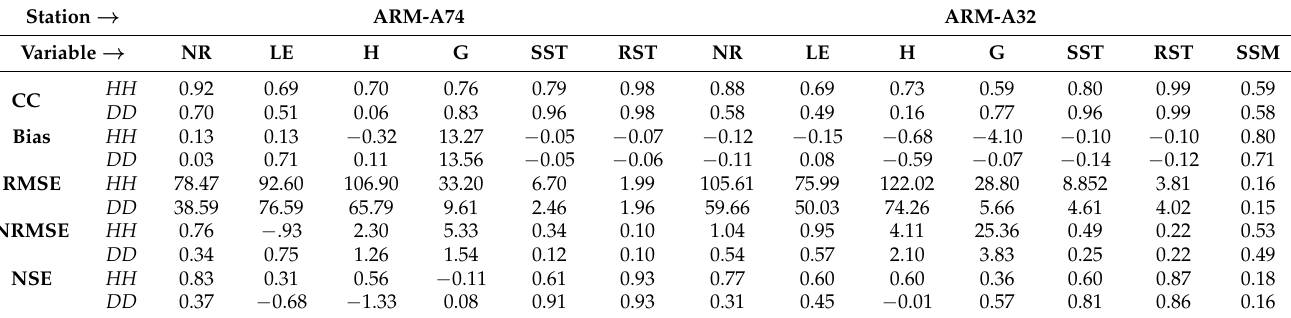
Table 10. ARM-CF to ARM-A74 and MOISST to ARM-A32 model parameter transfer evaluation statistics with respect to observed values at hourly (HH) and daily (DD) resolutions. Net radiation (NR, W/m 2 ), latent heat flux (LE, W/m 2 ), sensible heat flux (H, W/m 2 ), ground heat flux (G, W/m 2 ), soil surface temperature (SST, ◦ C), root-zone soil temperature (RST, ◦ C), and surface soil moisture (SSM, -). The statistical metrics are correlation coefficient (CC), bias, root mean squared error (RMSE), normalized RMSE (NRMSE), and Nash–Sutcliffe model efficiency coefficient